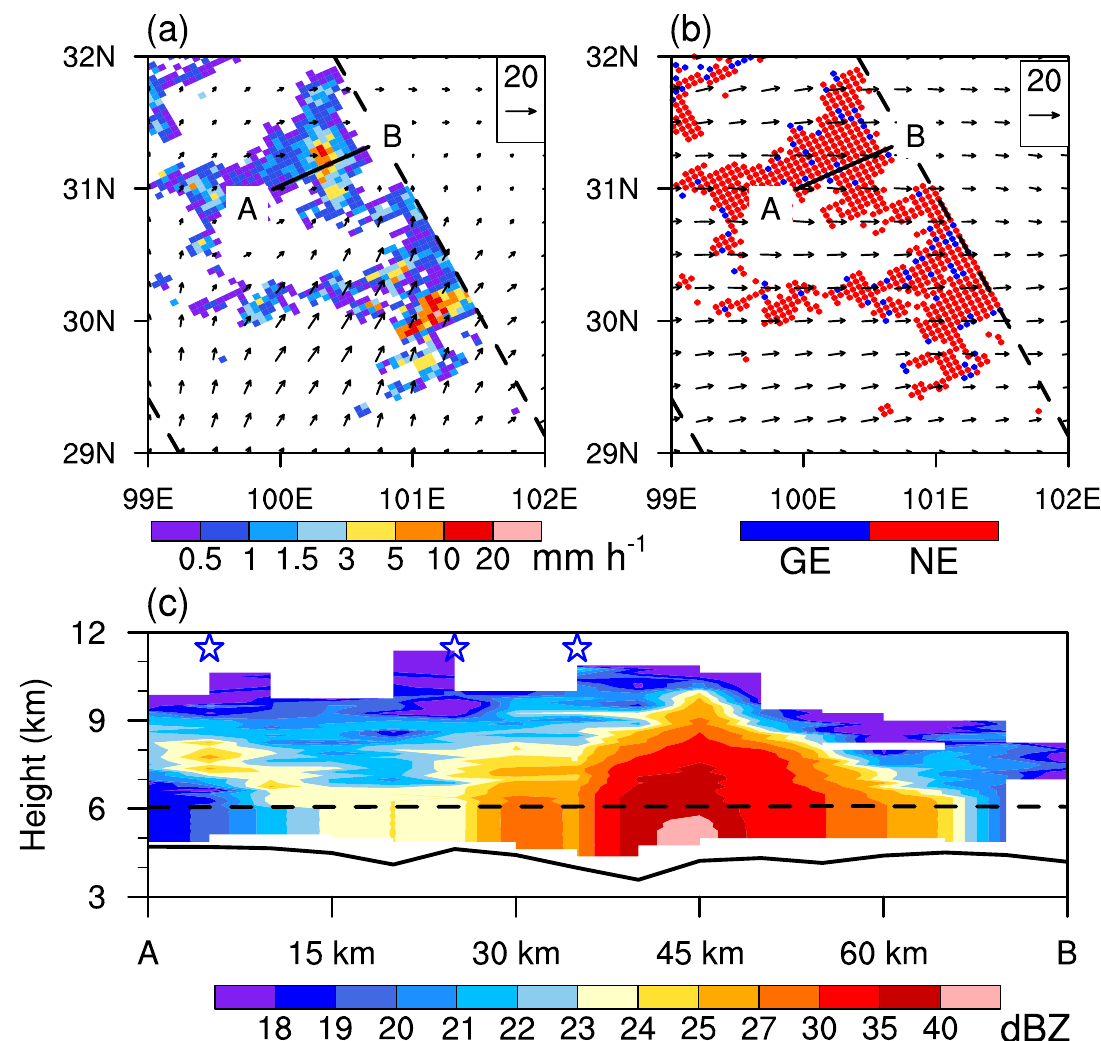
Fig. 1 Ghost echo case. a Near-surface rain rate and 550-hPa wind fi eld. b Ghost-echo identi fi cation and 400-hPa wind fi eld, in which blue denotes a ghost echo and red a normal echo. c Radar re fl ectivity of cross-section AB, in which pentagrams indicate the locations of ghost- echo pixels. The dashed lines in ( a ) and ( b ) indicate the scanned swath of the radar. The dashed line in ( c ) indicates the freezing height. The solid line in ( c ) indicates the